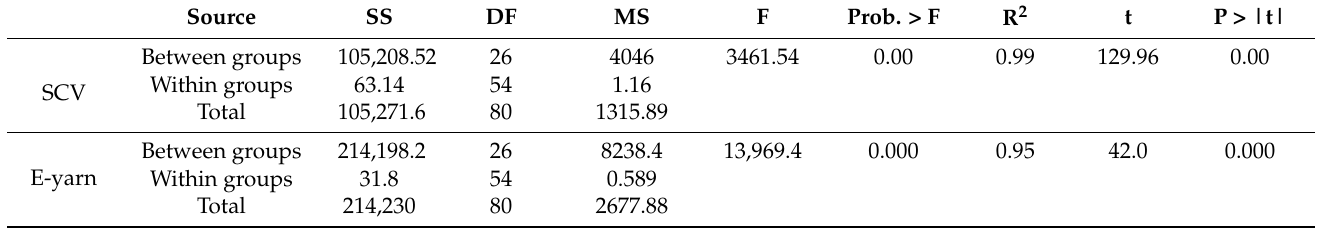
Table 3. Statistical analysis of effects of abrasion on electrical resistance.